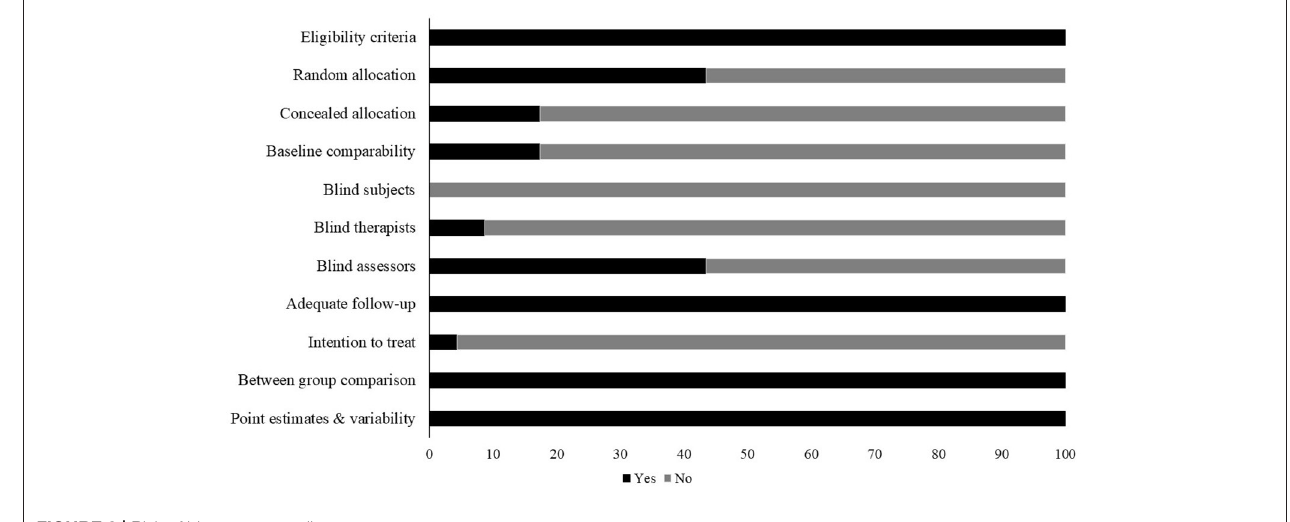
FIGURE 2 | Risk of bias across studies.